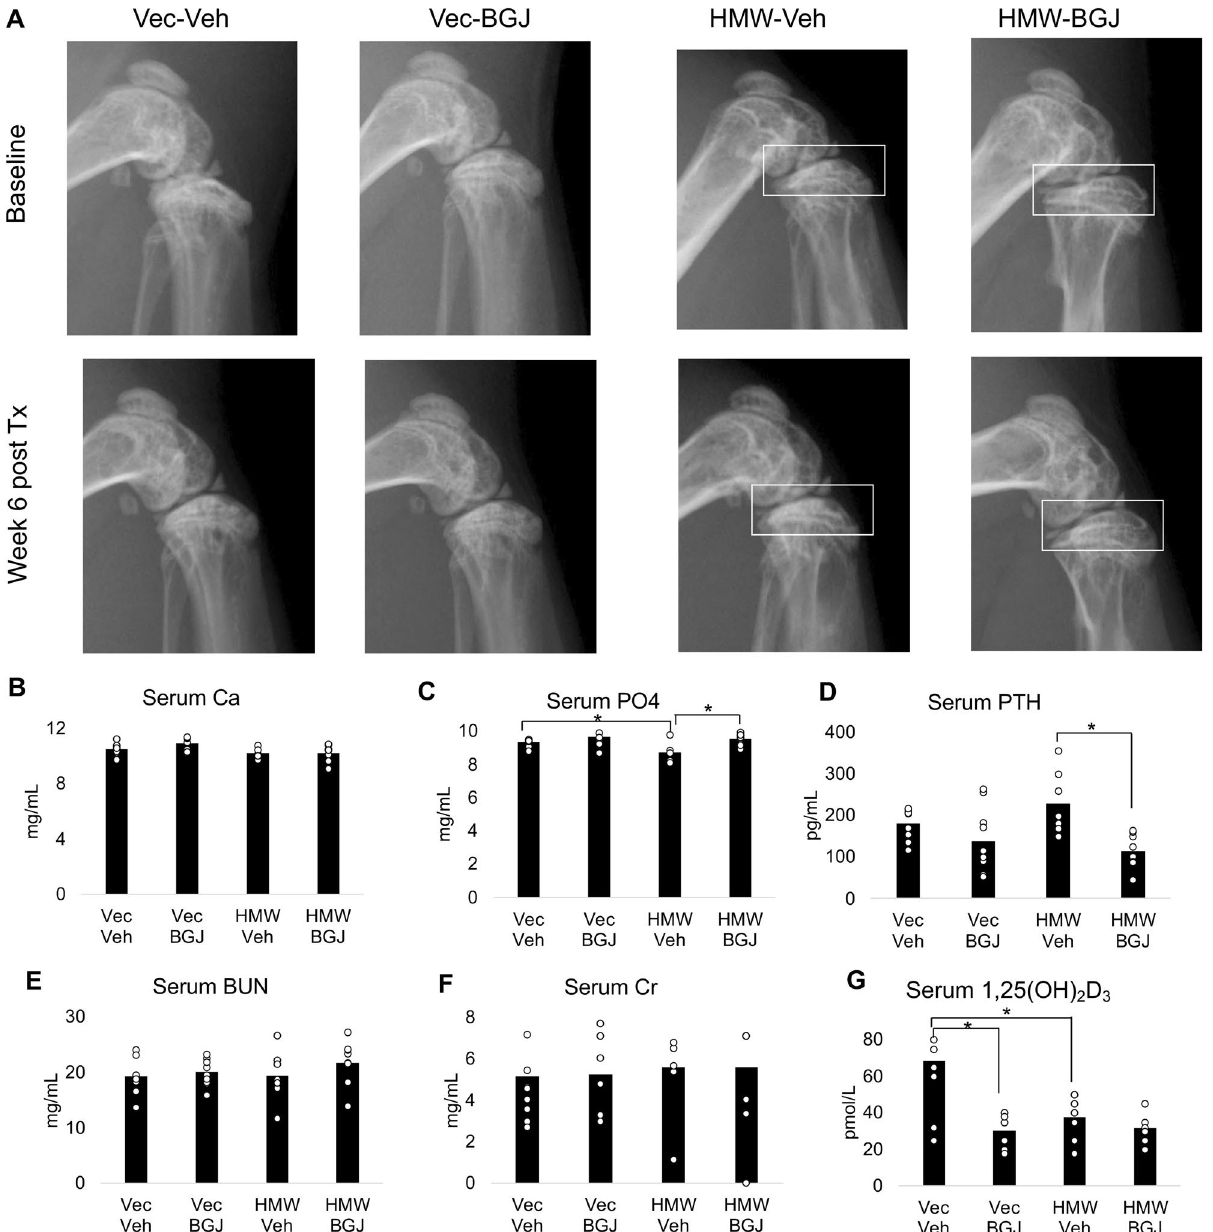
Figure 1. Knee X-rays and serum biomarkers of 9.5-month-old Vector-Control and HMWTgFGF2 mice treated with BGJ398. Eight-month-old Vector-Control (Vec) and HMWTgFGF2 (HMW) female mice were sq injected with vehicle or BGJ398 5 days/week for 6 weeks. ( A ) Representative digital X-ray image at baseline and at the end of treatment. X-rays showed the flattened tibia plateau and uneven joint surfaces in the HMWTgFGF2 mice before treatment, these were partially reversed by BGJ398 treatment but not with vehicle treatment (boxes). Representative images from n = 7–9 mice/group. Serum was collected during euthanasia at the end of experiment for serum biochemistry measurement ( B – G ). ( B ) Serum calcium, ( C ) phosphate, ( D ) parathyroid hormone, ( E ) blood urea nitrogen, ( F ) creatinine, ( G ) 1.25 dihydroxy vitamin D3. Data are shown as mean and individual points. n = 7–9 mice/group. * p < 0.05 by two-way sional Micro-CT images Fig. 2B, reveal thinning and less subchondral bone in the HMWTgFGF2 vehicle-treated group, that was rescued by BGJ398 treatment. Morphometric parameters calculated from 3-dimensional Micro- CT of femoral epiphyses (Fig. 2C) showed significantly decreased bone volume per total volume (BV/TV) in HMWTgFGF2 mice, that was significantly increased by BGJ398. However, reduced trabecular thickness (Tb.Th; Fig. 2D), trabecular number (Tb.N; Fig. 2E), and increased trabecular spacing (Tb.Sp; Fig. 2F) were all found in femoral epiphysis of HMWTgFGF2 vehicle-treated knees, compared with Vector-Control vehicle-treated epi- physes, without rescue by BGJ398 treatment. Histomorphometry analysis of the femoral subchondral bone from